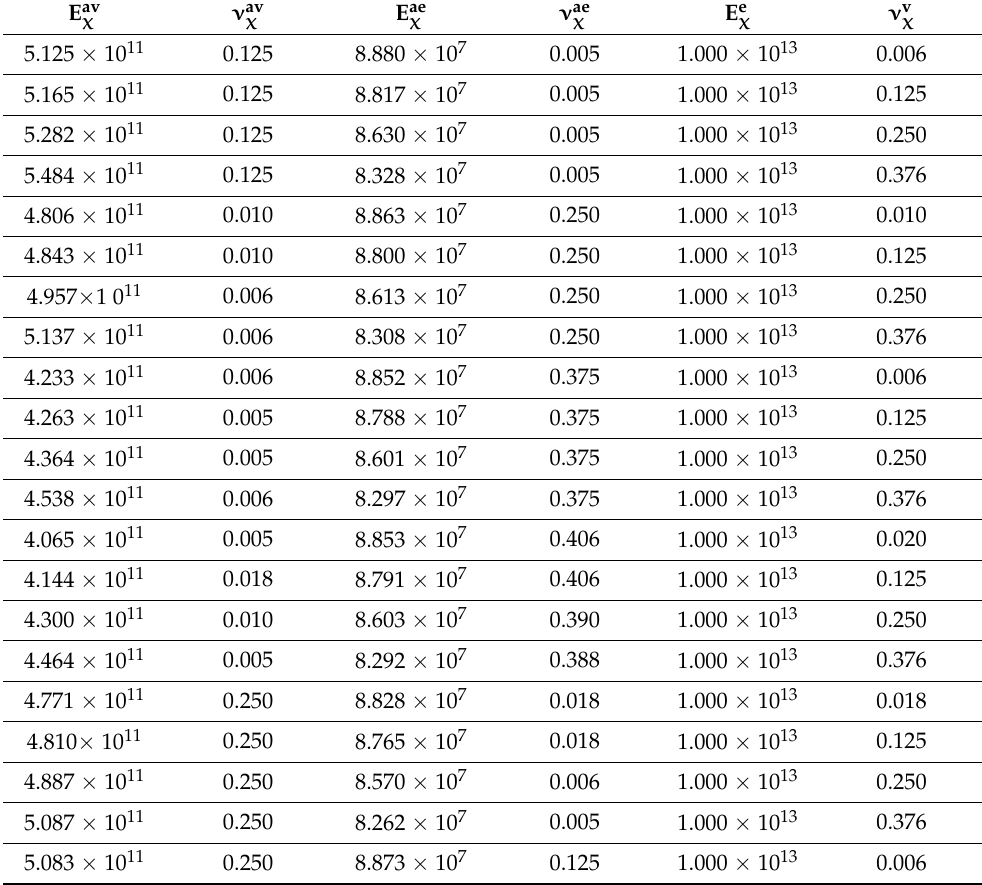
Inverse identification results for the case n = 4 ( I 1 = [ 0.005,0.125 ] , I 2 = [ 0.125,0.25 ] , I 3 = [ 0.25,0.375 ] and I 4 = [ 0.375,0.5 ]